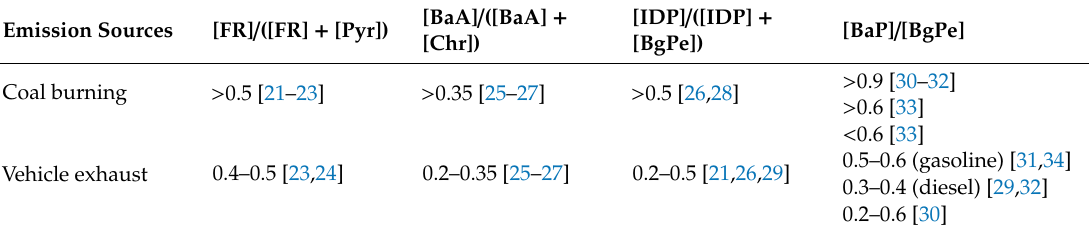
Table 2. Diagnostic ratios of PAH from previous studies.